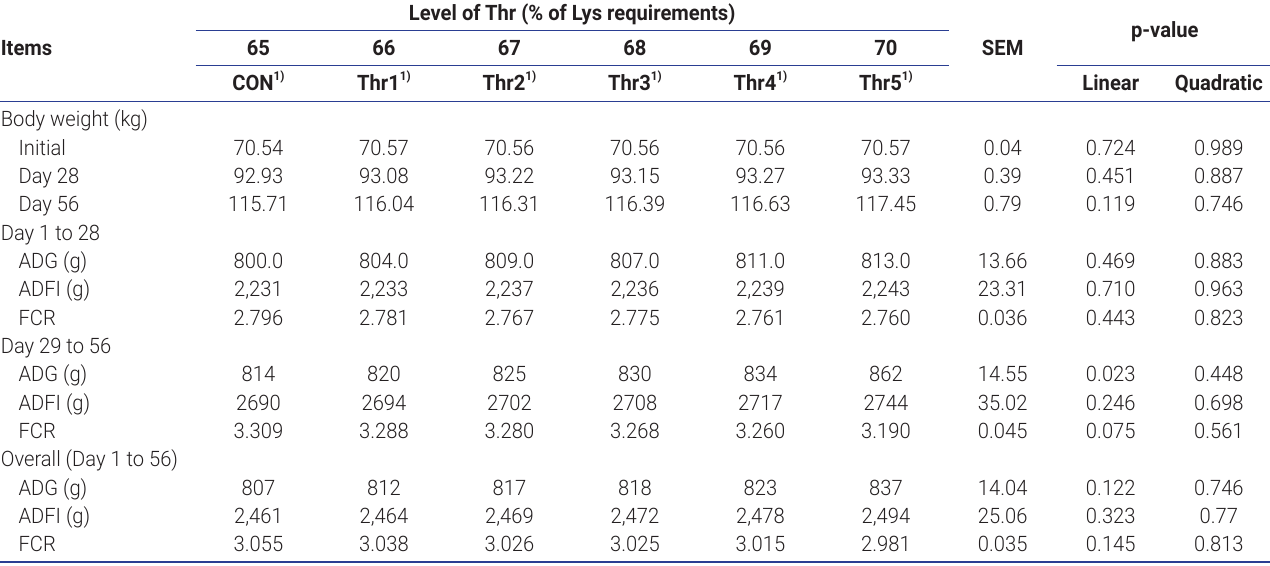
Table 2. Effect of varying dietary Lys:Thr ratios on growth performance in finishing pigs 1)